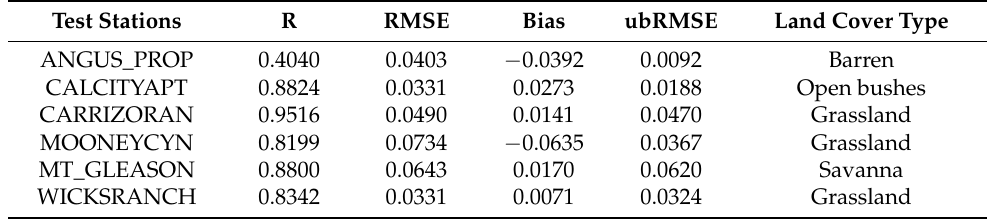
Table 4. Accuracy statistics of the six unmodeled measurement